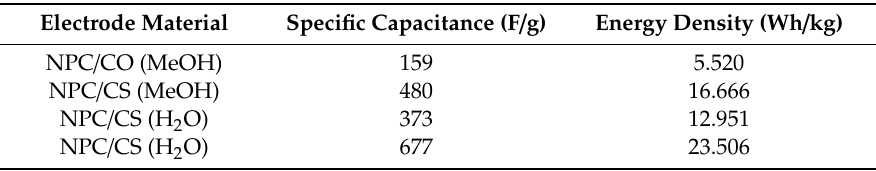
Table 3. Specific capacitance calculated from cyclic voltammetry.